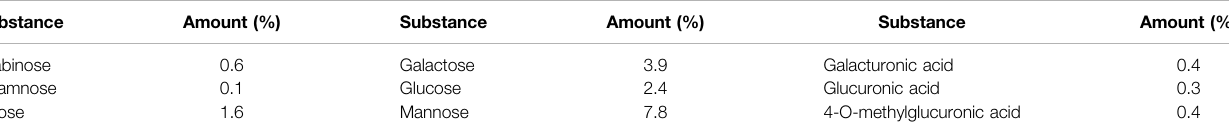
TABLE 2 | Hemicellulose content of LCC 80/20 analyzed by GC-FID. Substance